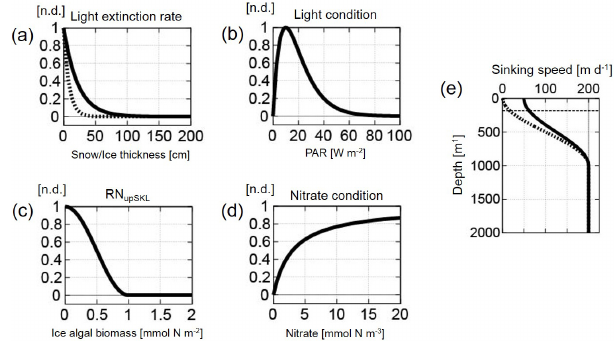
Figure 3. Relationships of (a) light extinction rate (non- dimensional (n.d.)) vs. thickness of (dashed line) snow and (solid line) sea ice (cm), (b) light condition term (n.d.) vs. light intensity (PAR) (Wm − 2 ) , (c) ice nutrient uptake ratio RN upSKL (n.d.) vs. ice algal biomass (mmolNm − 2 ) , (d) nitrate condition term (n.d.) vs. nitrate concentration (mmolNm − 3 ) , and (e) sinking speed of PON derived from (solid line) ice algae and (dashed line) pelagic plank- ton groups (md − 1 ) vs. depth in the water column (m), respectively, in the Arctic NEMURO model. See more information in Sect.